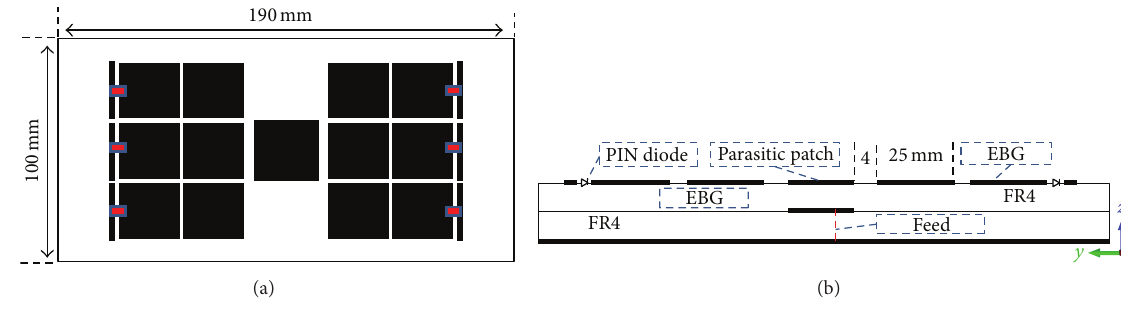
Figure 1: Geometries of the switchable SWA: (a) top view, EBG based antenna layer with PIN diode switches, (b) side view.